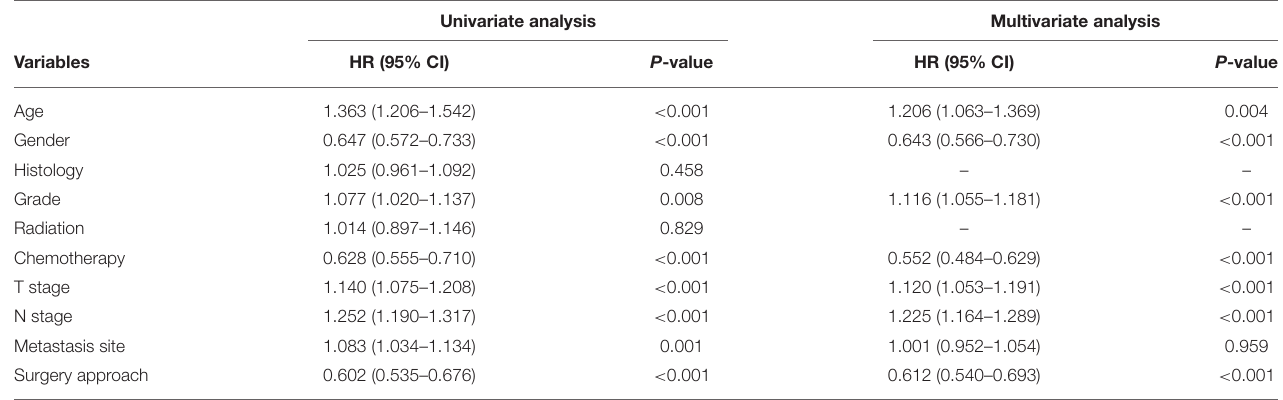
TABLE 5 | Univariate and multivariate analysis of clinicopathological characteristics for OS of the surgical patients. Univariate analysis